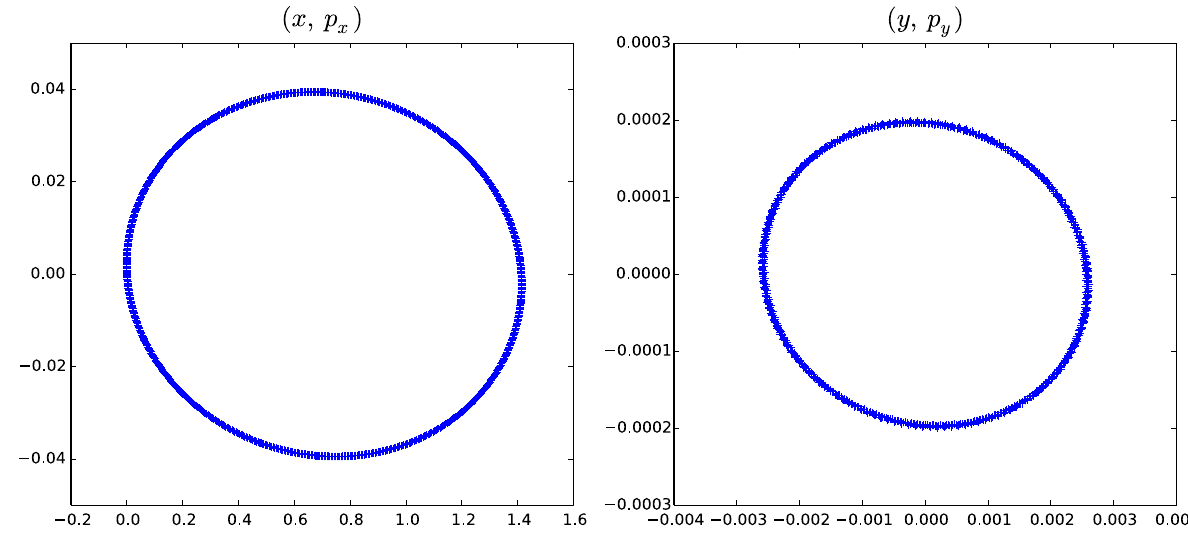
FIG. 4. Horizontal and vertical phase space with the corrected (symplectic) code. The units are [m] and [rad]